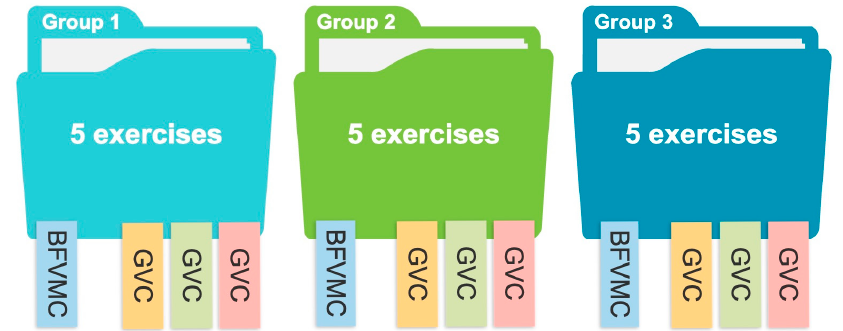
Figure 3. Each group of exercises stimulates one of the Basic Factors of Visual-Motor Cognitive (BFVMC) aptitudes, and the three Groups of Visual Comprehension (GVC).